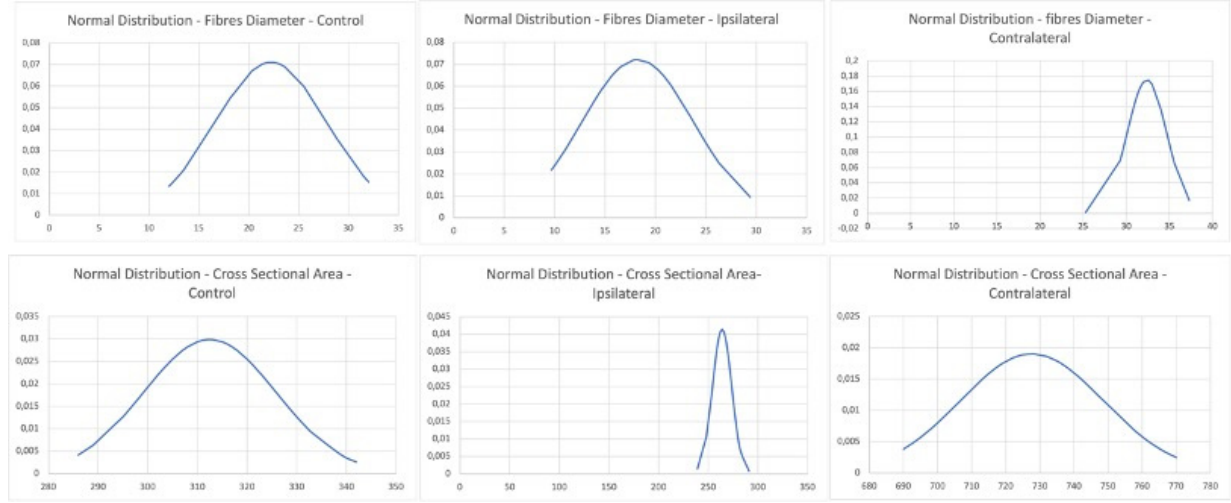
Figure 6. Compound panel of Gaussian curves showing the normal distribution of fiber diameters and cross-sectional area values for the control and for both ipsilateral and contralateral muscles of the crossbite group.